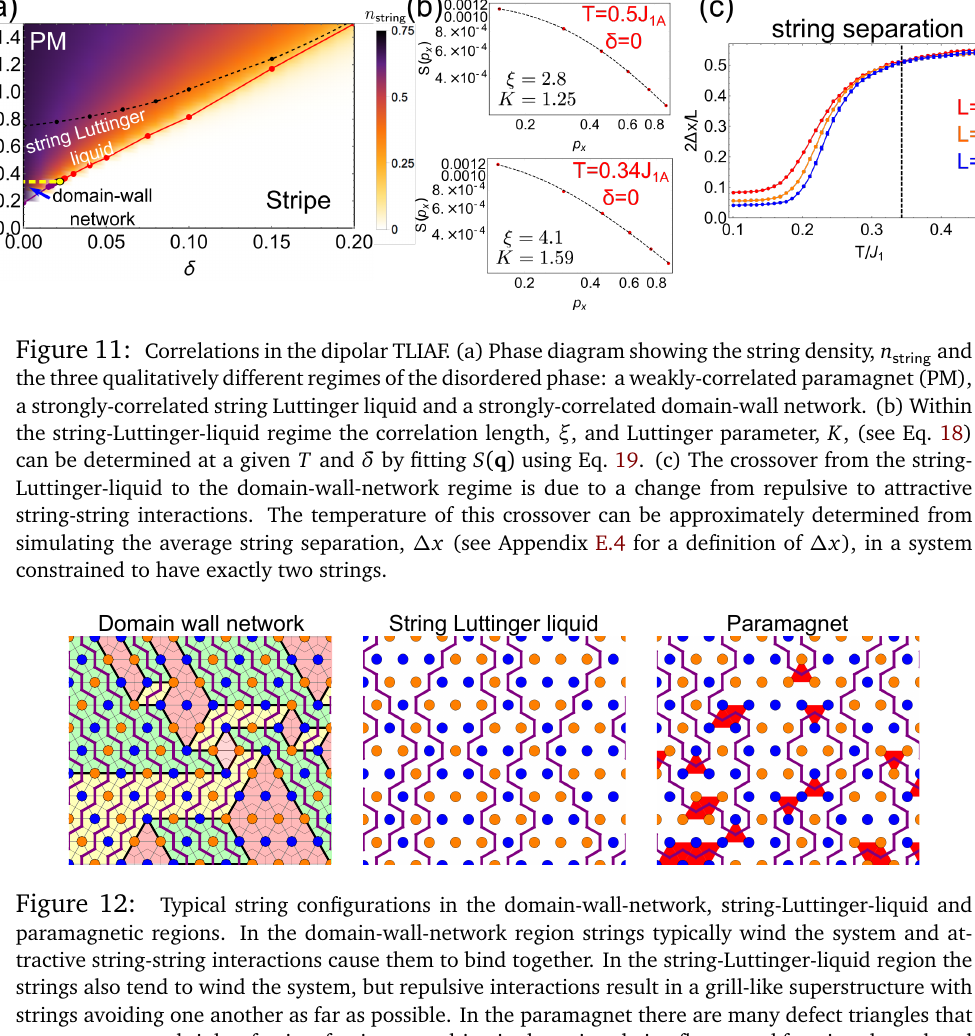
Figure 12: Typical string configurations in the domain-wall-network, string-Luttinger-liquid and paramagnetic regions. In the domain-wall-network region strings typically wind the system and at- tractive string-string interactions cause them to bind together. In the string-Luttinger-liquid region the strings also tend to wind the system, but repulsive interactions result in a grill-like superstructure with strings avoiding one another as far as possible. In the paramagnet there are many defect triangles that act as sources and sinks of pairs of strings, resulting in the strings being floppy and forming short closed